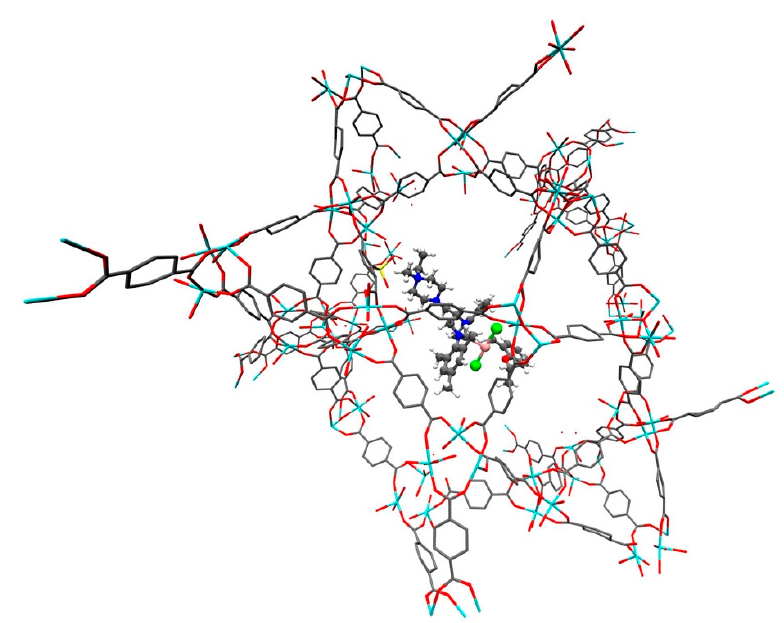
Figure 4. Snapshot of the MOF from the X-Ray with an inserted ammonium NHC-tagged olefin metathesis catalyst AquaMet TM in a cavity. Table 5. Relative energies in gas phase (in kcal / mol) of the intermediates for catalysts HOV, AquaMet TM and MOF-AquaMet TM , and including the model of MOF ((a) calculated by CP2K; (b) calculated by Gaussian (in parentheses values calculated without the correction of Martin, at 1 atm); (c) Gibbs free energies in gas phase).